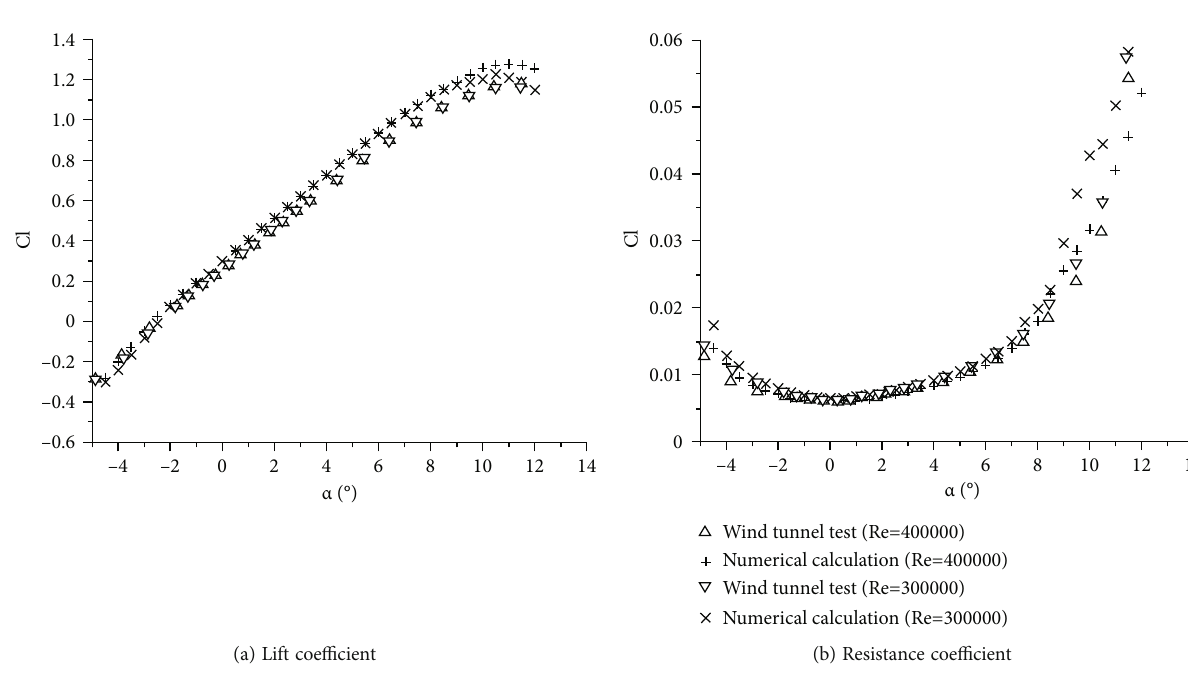
Figure 7: Schematic diagram of computational grid.